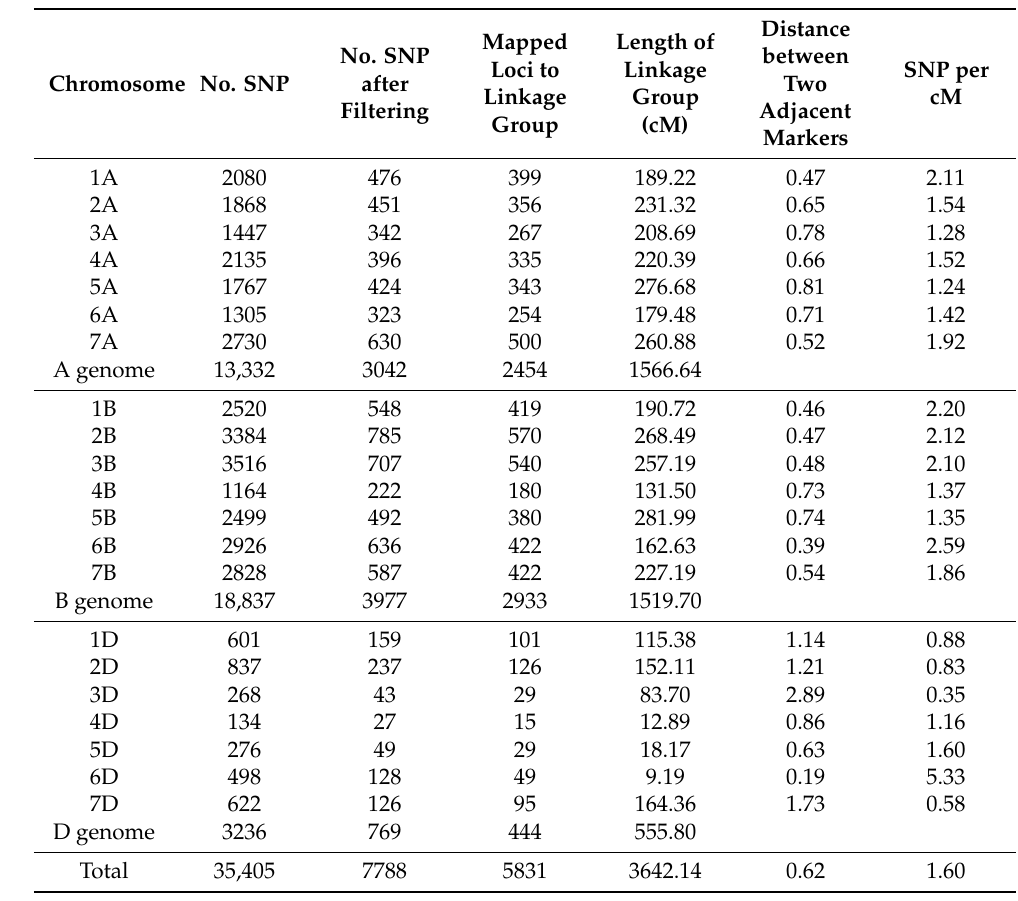
Table 2. Summary of the GBS markers mapped to the 21 chromosomes based on 148 recombinant inbred lines derived from a cross between #49 and Yecora